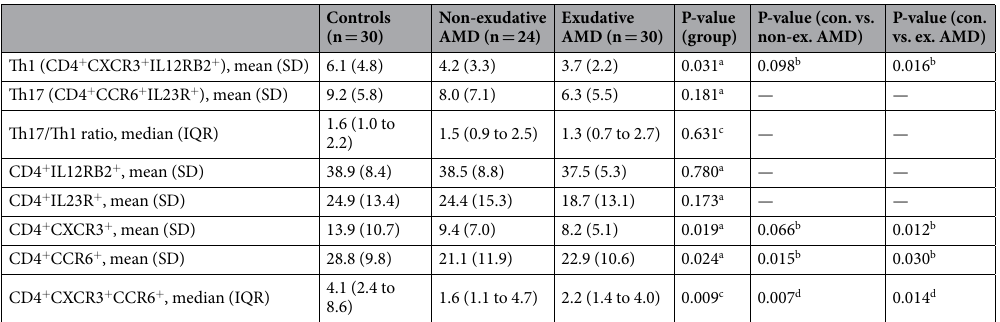
Non-exudative AMD (n = 24)